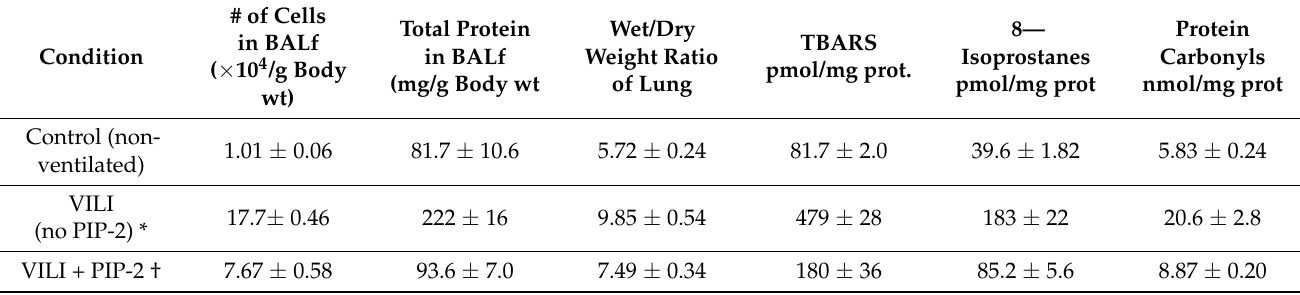
Table 5. Effect of PIP-2 on manifestations of VILI in female mice. Female mice were ventilated with parameters the same as for male mice (tidal volume 12 mL/Kg, respiratory rate 120/min, and PEEP 2 cm H 2 O). Mice were administered PIP-2 (2 µ g/g body weight) encapsulated in liposomes by an IV bolus injection. Mice were sacrificed after 6 h, and lungs were cleared of blood, lavaged, and processed as described in Materials and Methods. Results are mean ± SD for n = 4. * p < 0.05 vs. Control and vs. VILI + PIP-2; † p < 0.05 vs. Control and vs. VILI. Statistics represent all values in the indicated row.